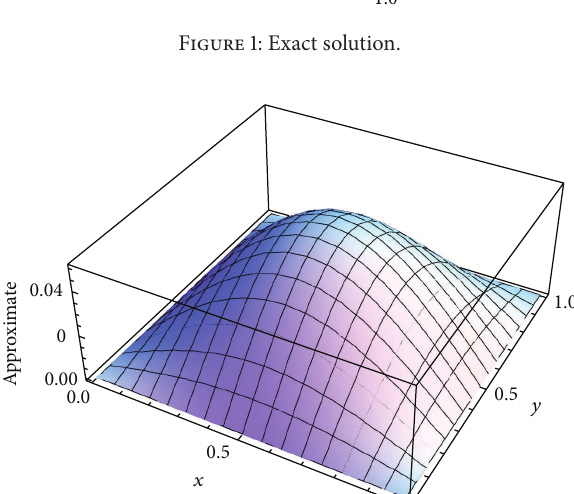
Figure 1: Exact solution.